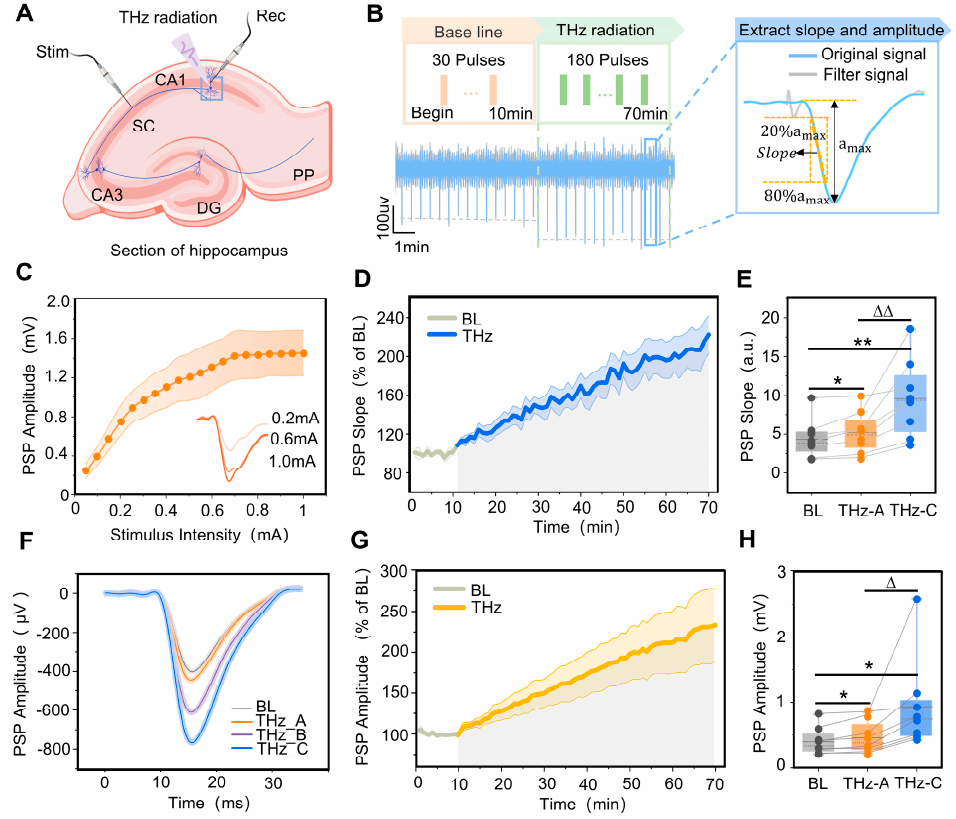
Figure 3. Terahertz wave modulation of synaptic transmission efficiency in the CA1 region of rat hippocampi. ( A ) Location of stimulation electrodes and recording electrodes in ventral sections of rat hippocampi. ( B ) Terahertz radiation protocol, and the method for extracting the slope and amplitude of postsynaptic potential (PSP) in the CA1 region of the hippocampus. ( C ) With the increase in stimulation intensity, the CA1 PSP amplitude gradually increased and stabilized near the maximum value. ( D ) The variation pattern of the CA1 PSP descent slope with terahertz radiation time, where the baseline (BL) is 10 min (grey curve) and terahertz radiation (THz) is 60 min (blue curve). The PSP descent slope was normalized. ( E ) The slopes of the PSP at 0–5 min (THz_A) and 55–60 min (THz_C) of teraher tz radiation were signi fi cantly higher than the BL; THz_A < THz_C. Data are mean ± SEM ( n = 8 independent experiments). *, p < 0.05. **, p < 0.01, compared with BL. ∆∆ , p < 0.01, THz_C vs. THz_A, Paired t -test. ( F ) Representative maps of BL, THz_A, teraher tz radiation 25–30 min (THz_B) and THz_C PSP in the hippocampal CA1 region. ( G ) The variation pa tt ern of CA1 PSP amplitude with teraher tz radiation time, where the BL is 10 min (grey curve) and THz 60 min (yel- low curve). The PSP amplitude was normalized. ( H ) The amplitudes of the PSP at THz_A and THz_C were signi fi cantly higher than the BL; THz_A < THz_C. Data are mean ± SEM ( n = 8 inde- pendent experiments). * p < 0.05, compared with BL, ∆ , p < 0.05, THz_C vs. THz_A, paired t -test. To further investigate the duration of 0.138 THz radiation to improve the synaptic transmission e ffi ciency in the CA1 region of the hippocampus, we analyzed the changes in the slope and amplitude of the postsynaptic potentials in the CA1 region within 10 min of the end of teraher tz radiation. The teraher tz radiation protocol is shown in Figure 4A. The results showed that the postsynaptic potential slope and amplitude were relatively stable within 10 min of the end of teraher tz radiation, as shown in Figure 4B,D,E. Further statistical analysis revealed that the slope of postsynaptic potentials in the hippocampal CA1 region was signi fi cantly higher than the baseline (4.73 ± 1.19) at 0–5 min and 5–10 min (12.80 ± 3.51, 12.50 ± 3.39) from the end of teraher tz radiation, as shown in Figure 4C,F. Additionally, the amplitude of postsynaptic potentials (1159.60 ± 334.47, 1142.70 ± 326.15) was signi fi cantly higher than the baseline (421.12 ± 97.04).